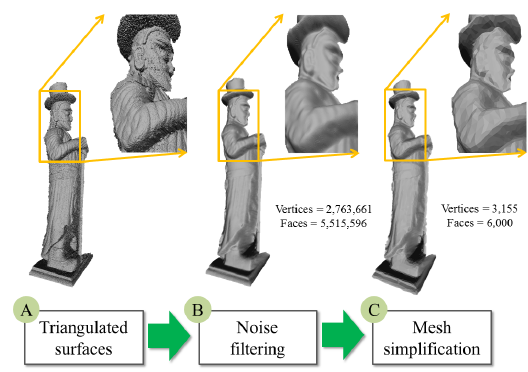
Figure 8: Mesh processing: triangulated surfaces from point clouds, noise reduction and mesh simplification.